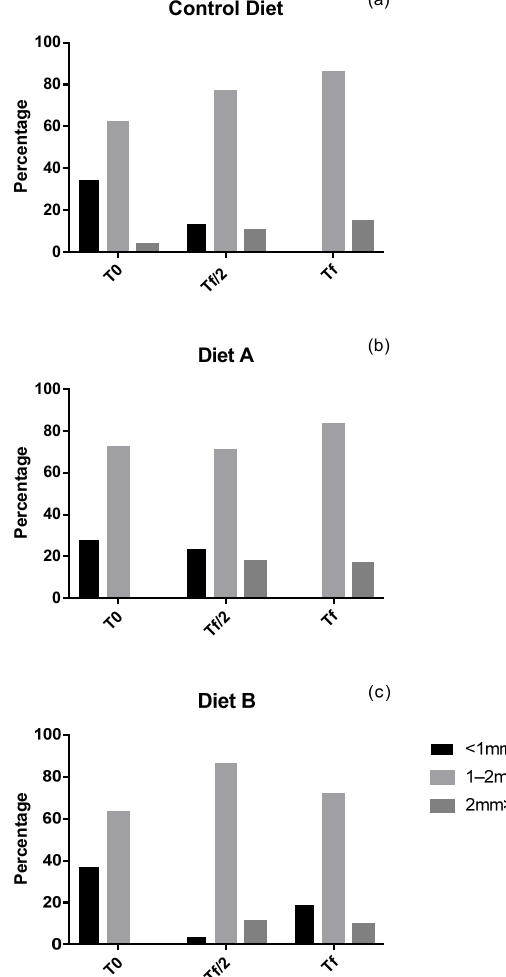
Figure 3. Size-frequency histograms of P. lividus post-larvae feeding of ( a ) control diet ( U. rigida ), ( b ) diet A ( U. rigida , SHG ® microperle, Algamac Enrich), ( c ) and diet B ( U. rigida , spirulina SHG ® ) at three experimental times (T 0 = start of the experiment; T f/2 = 40th day; T f = 82nd day).